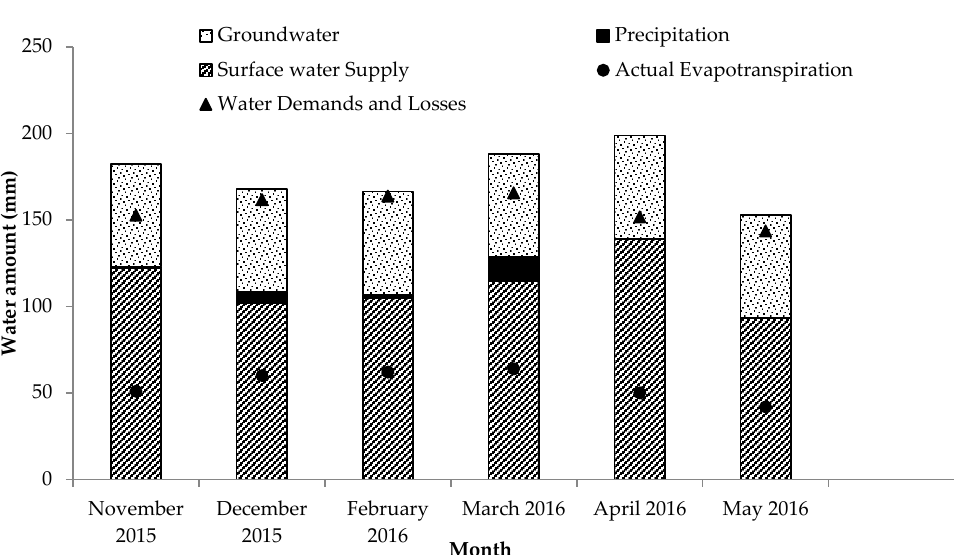
Figure 5. Monthly water balance of the study area during the winter season (from November 2015 to May 2016).